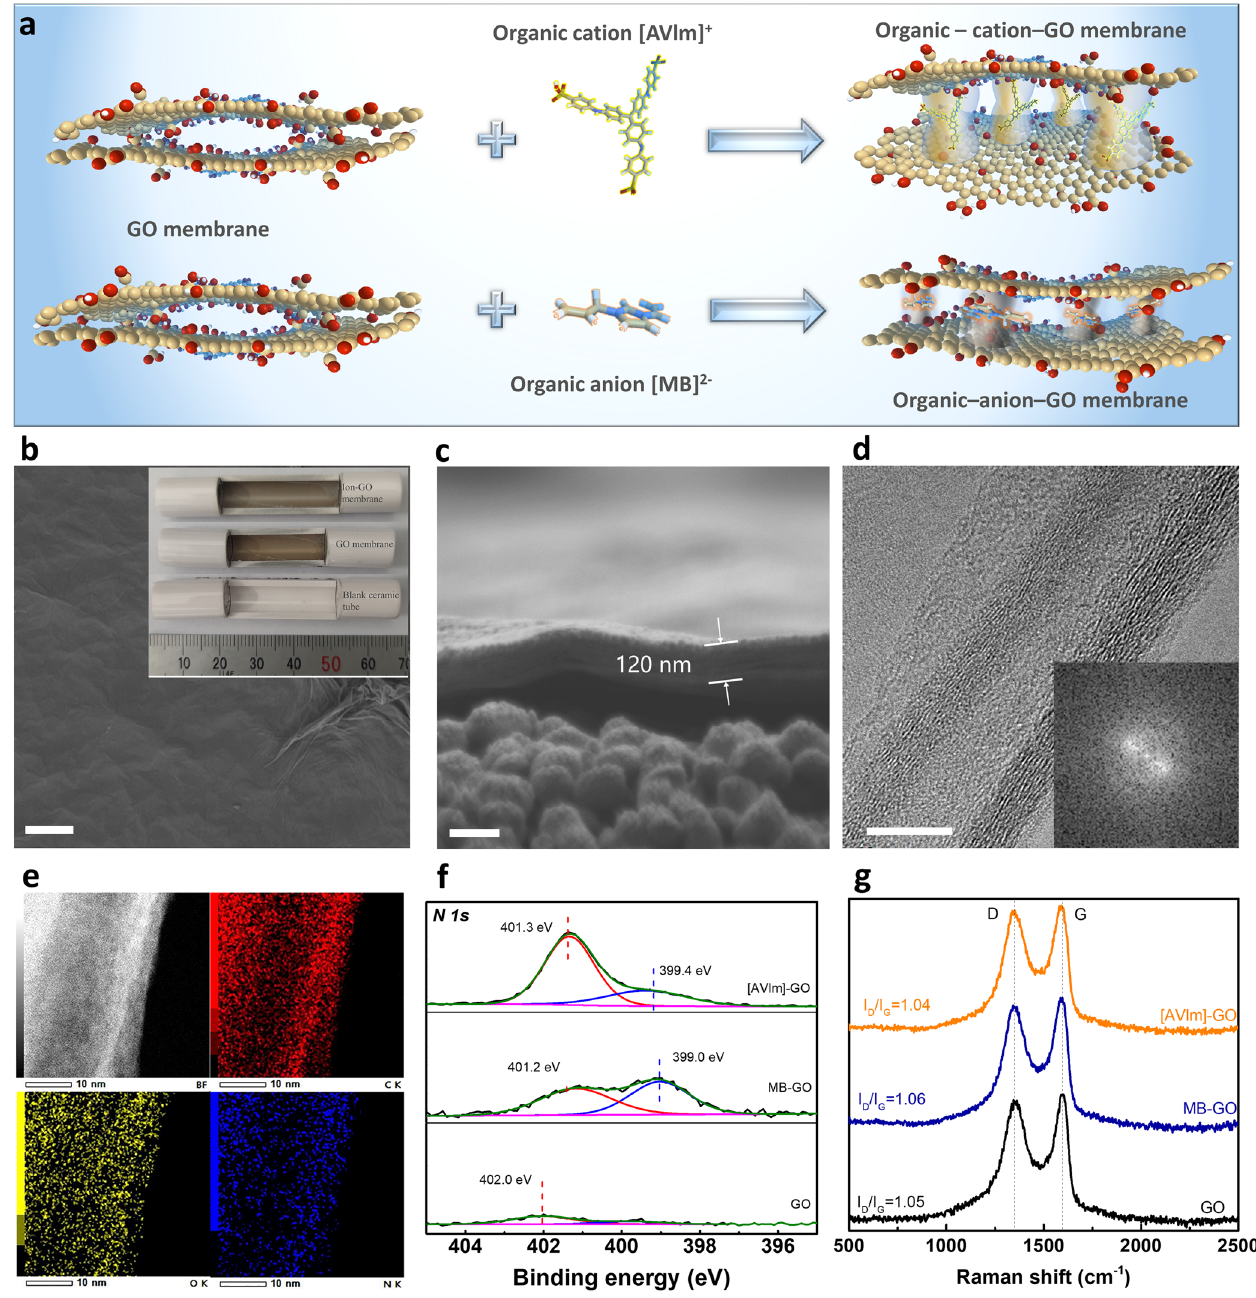
Fig. 1 Organic ions intercalation into GO membranes. a Schematic of organic ion-intercalation between the interlayers of GO fl akes by using [AVlm] cations and [MB] anions as examples. SEM ( b ) surface and c cross-sectional views of MB-GO membrane ( b inset: Optical image of the dissected porous ceramic tube and supported GO and MB-GO membranes). d TEM image of MB-GO fragment (Inset: the fast Fourier transform of TEM image). e Elemental mapping of [AVlm]-GO fragment. f XPS N 1 s spectra and g Raman spectra of GO, MB-GO, and [AVlm]-GO samples. Scale bars in b – d are 2 μ m, 200 nm, and 20 nm,